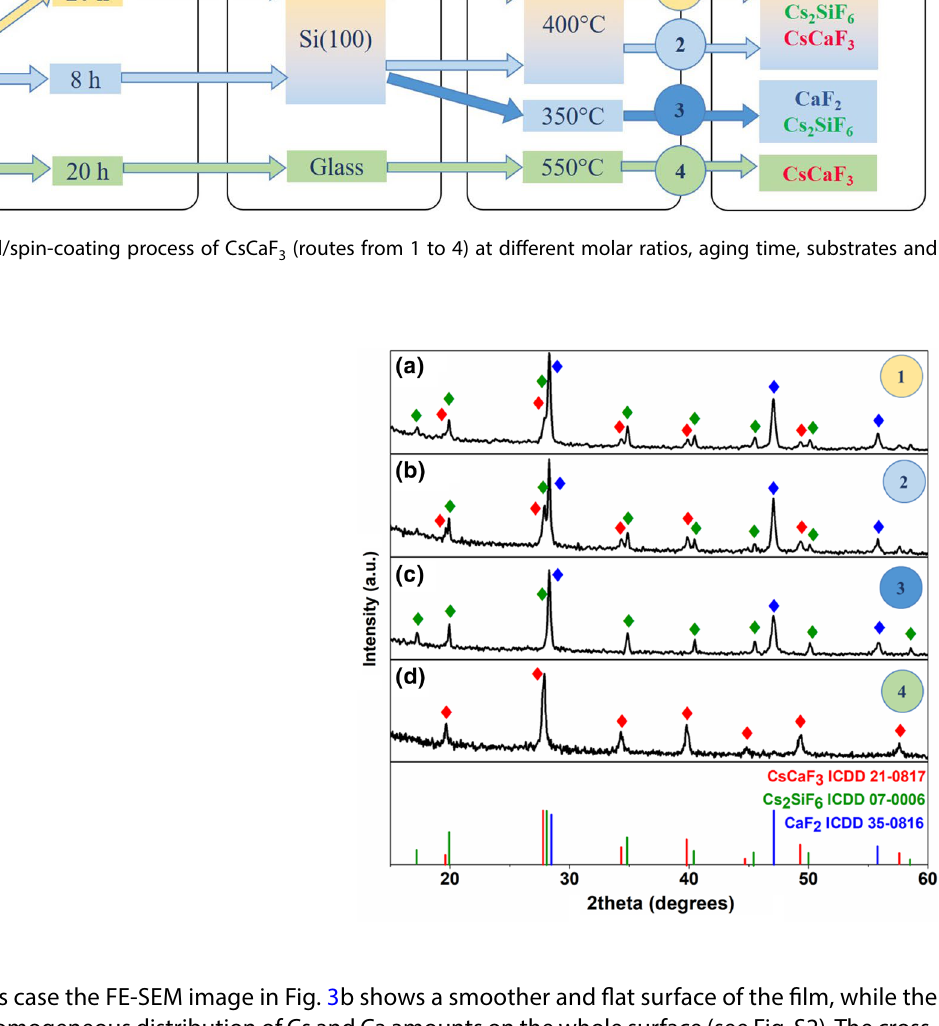
(routes from 1 to 4) at different molar ratios, aging time, substrates and 3